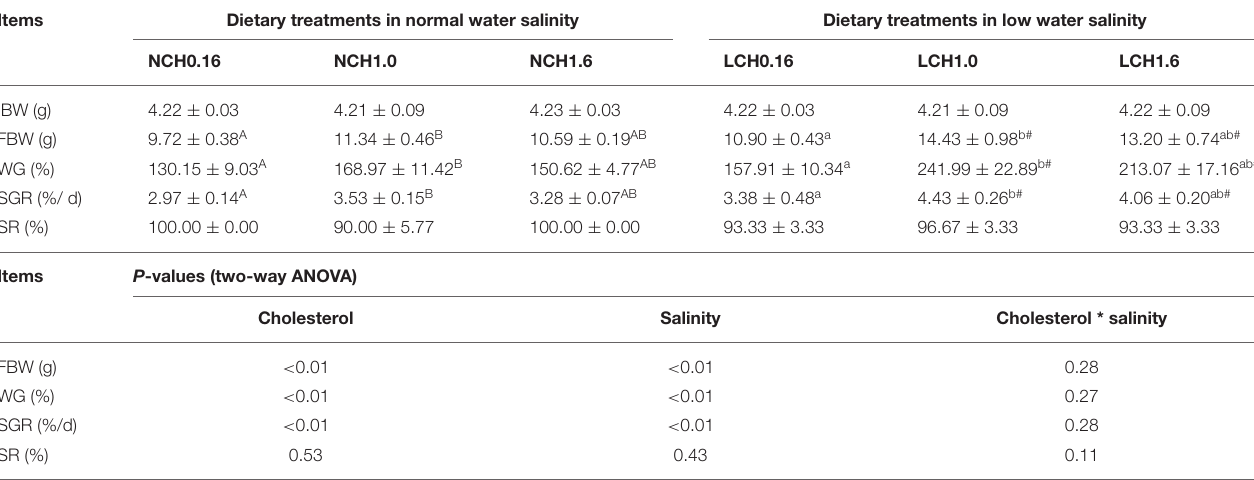
TABLE 1 | Growth performance of Acanthopagrusschlegelii fed experimental diet reared at different water salinity for 4